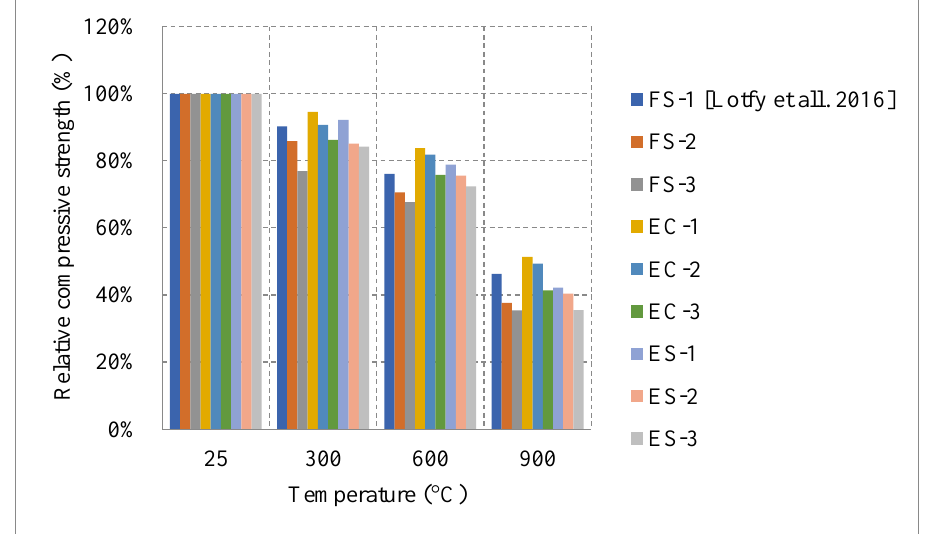
Figure 34. Relative compressive strength of naturally cooled LWSCC with different constituents 2. 1 = Casting by a pump injection system; 2 = Suitable for many normal applications; 3 = Suitable for vertical applications in very congested structures, structures with complex shapes, or for filling under formwork; FS = furnace slag; EC = expanded clay; ES = expanded shale [107]. Fiber reinforced SCC